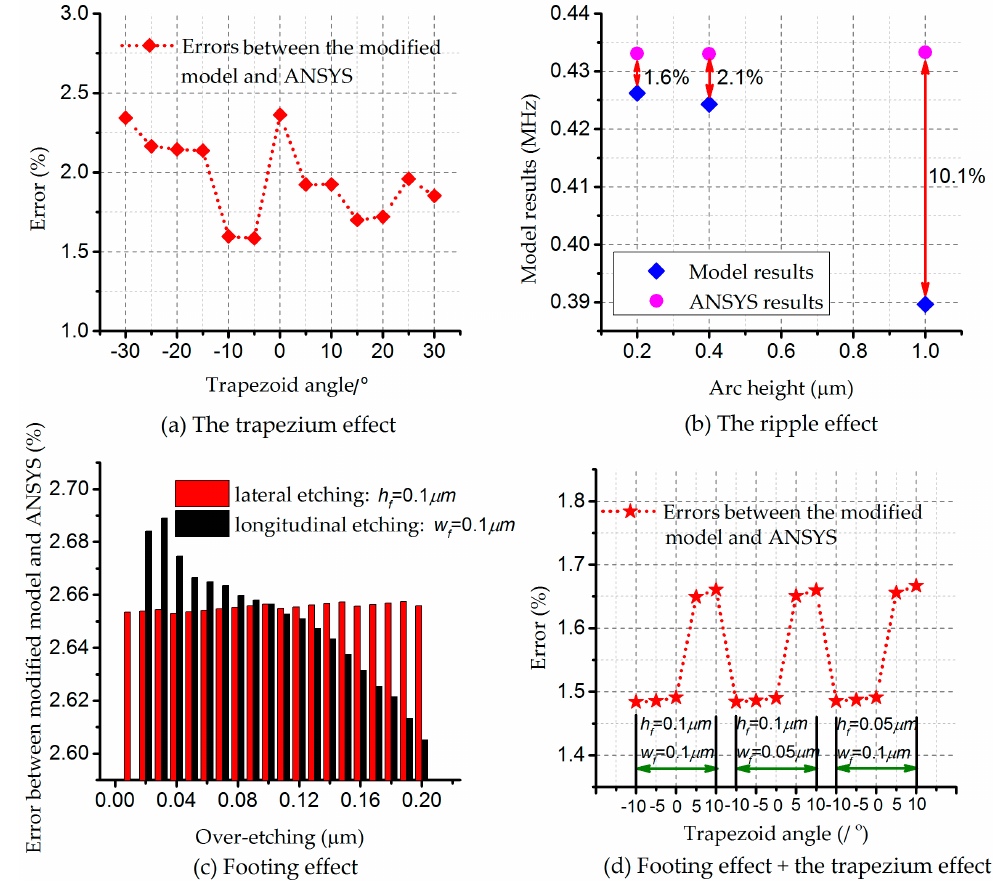
Figure 9. Comparisons between modified models and ANSYS while considering models related to Equations (3)–(6) (the errors along the vertical axis defined as: Error = |model results—ANSYS results|/model results): ( a ) the trapezium effect; ( b ) the ripple effect; ( c ) the footing effect, the red for lateral over-etching and black for over-etching longitudinally; and ( d ) the footing effect and the trapezium effect.